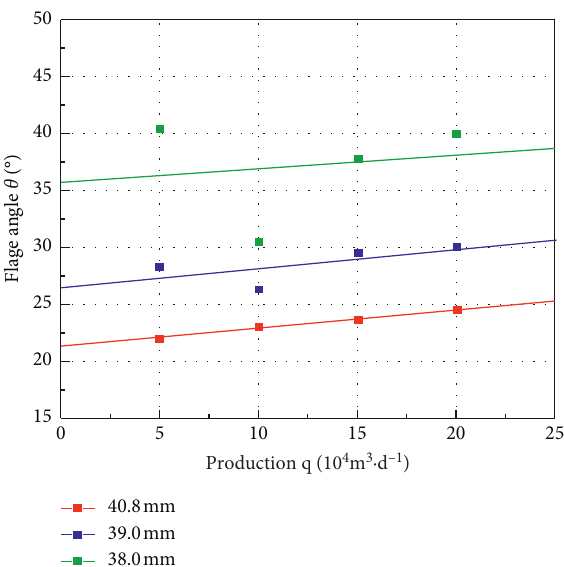
Figure 7: Relation between critical effective opening and production before regulation.